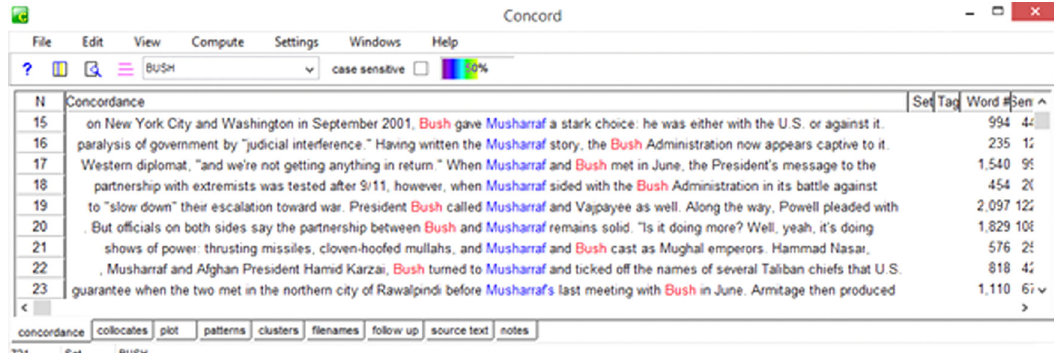
Fig. 7 Concordance extract. Concordance extract Bush – Musharraf*